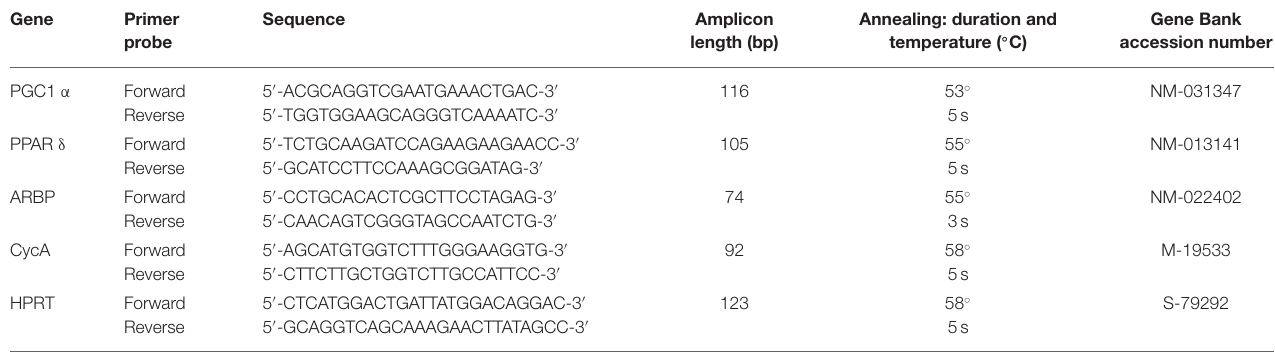
TABLE 1 | Oligonucleotide primers used for real-time PCR amplification.